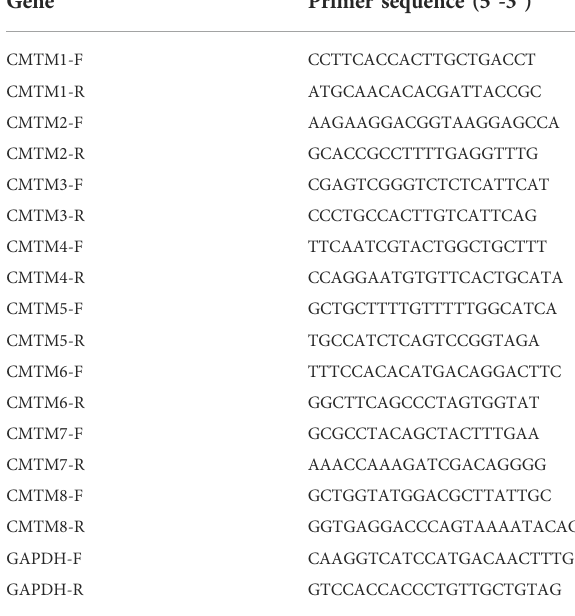
TABLE 1 Sequences of primers used for